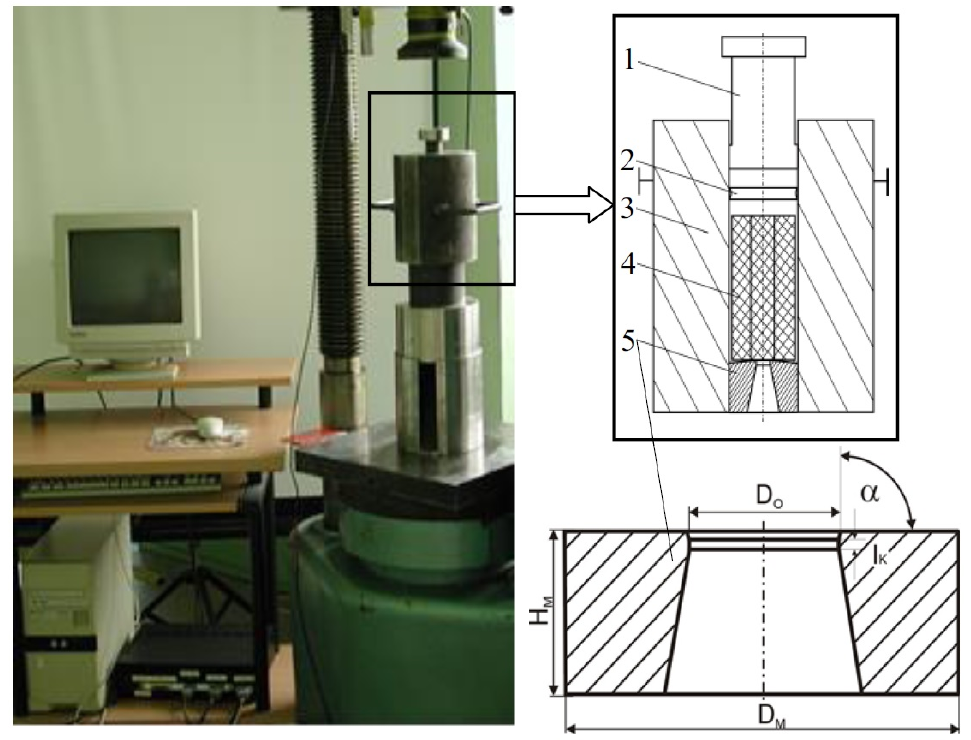
Figure 1. Experimental stand for the extrusion process and scheme of the die (1—punch, 2—pressure pad, 3—container, 4—billet, 5—die).